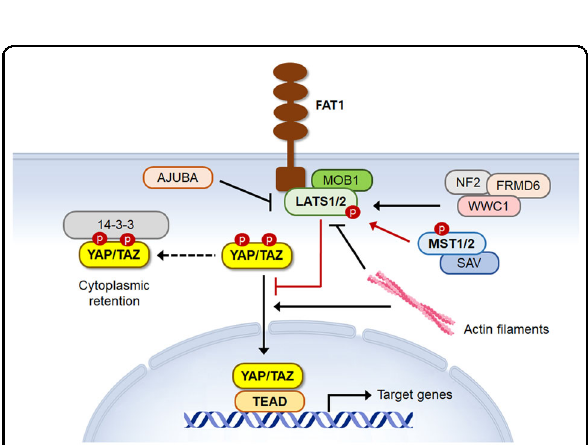
Fig. 3 Schematic representation of core components of the Hippo-YAP pathway. YAP and TAZ are regulated by Hippo kinases and their adapters. FAT1 supports the assembly and activation of Hippo signaling components. LATS-mediated phosphorylation promotes cytoplasmic retention of YAP and TAZ.